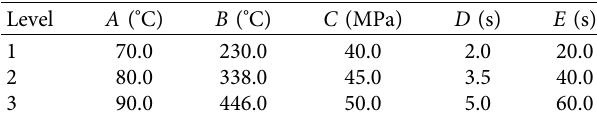
Table 16: Comprehensive design of test level